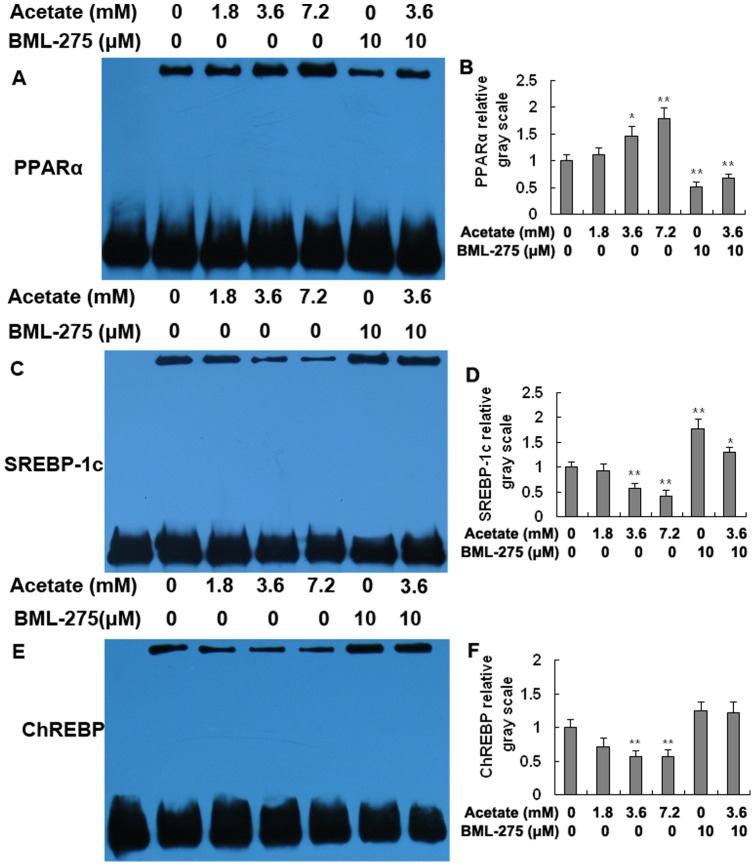
Transcriptional activity of PPARα, SREBP-1c, and ChREBP in hepatocytes.Hepatocytes were treated with acetate and BML-275 and divided into a control group (0 mM acetate), a low-dose acetate treatment group (1.8 mM acetate), a medium-dose acetate treatment group (3.6 mM acetate), a high-dose acetate treatment group (7.2 mM acetate), a BML-275 group (10 μM BML-275), and a BML-275+acetate group (10 μM BML-275+3.6 mM acetate). Acetate (sodium acetate) was used in the form of neutralized acetic acid to avoid changing the pH of the medium. A and B: EMSA results for PPARα. C and D: EMSA results for SREBP-1c. E and F: EMSA results for ChREBP. * p<0.05, ** p<0.01 versus the control group.